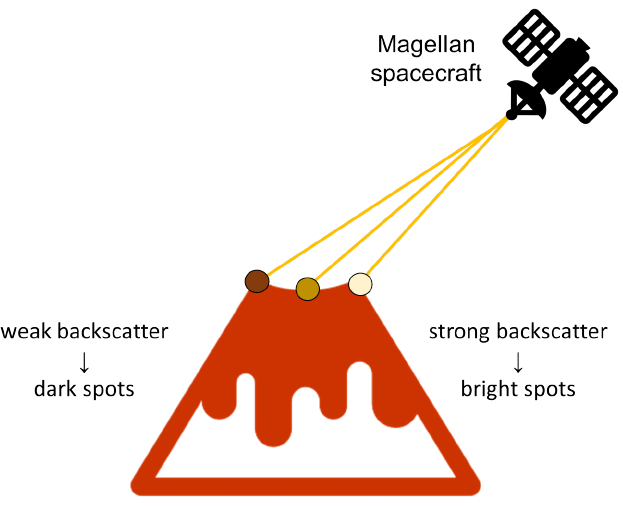
Figure 2. The reflection of the radar beam from the volcano [8].